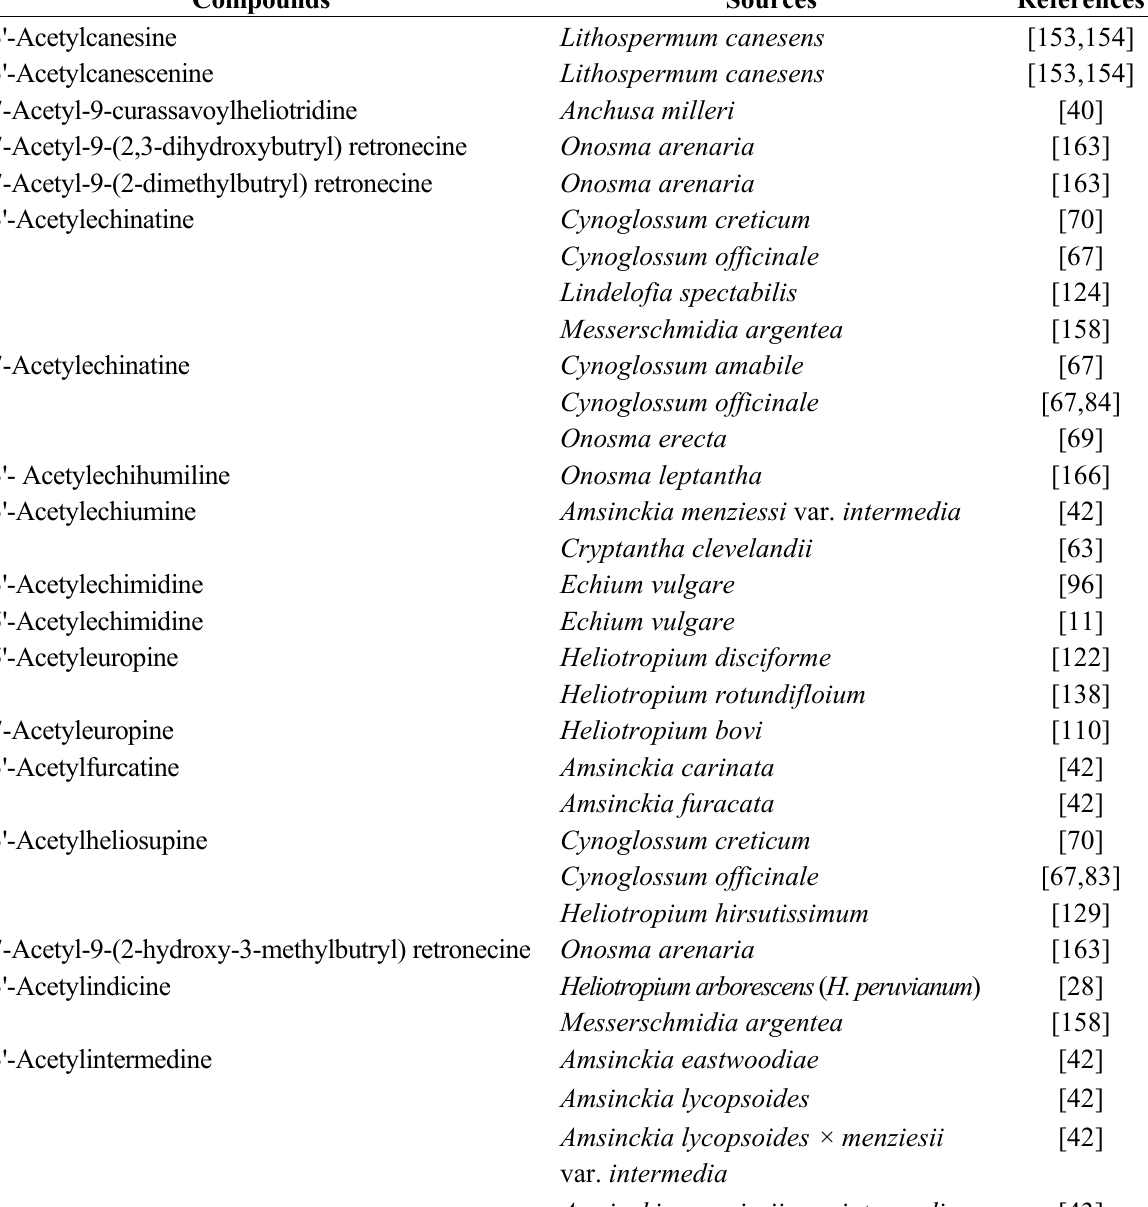
Table 2. Alkaloid composition of investigated species of Boraginaceae.